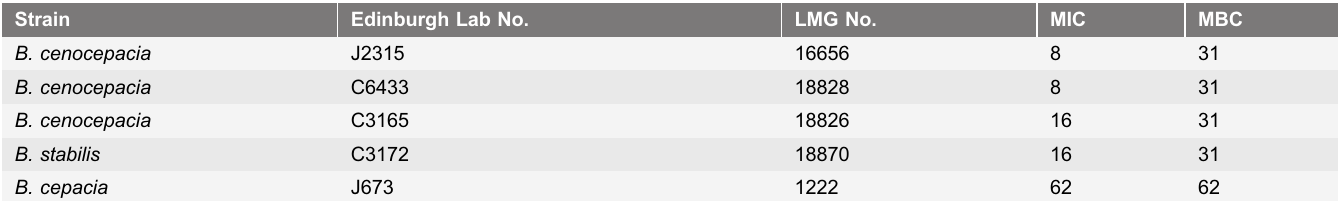
Table 2. MICs and MBCs ( m g/ml) of AAS for B. cepacia complex.